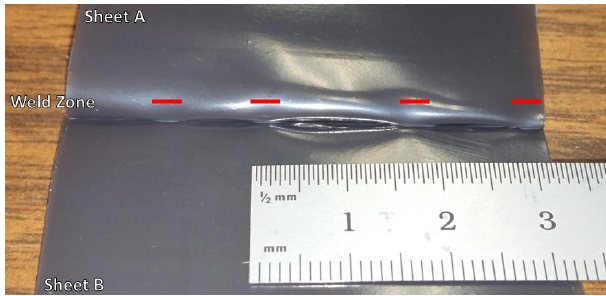
Figure 12. Laser weld not subjected to further mechanical testing. Broken/dashed linear indication represented a degraded weld seam between the LLDPE sheeting.